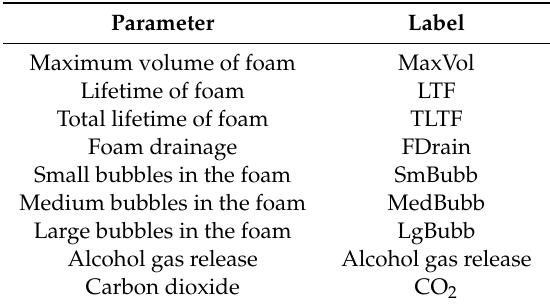
Table 2. Parameters analyzed using the robotic pourer RoboBEER . Parameter Label